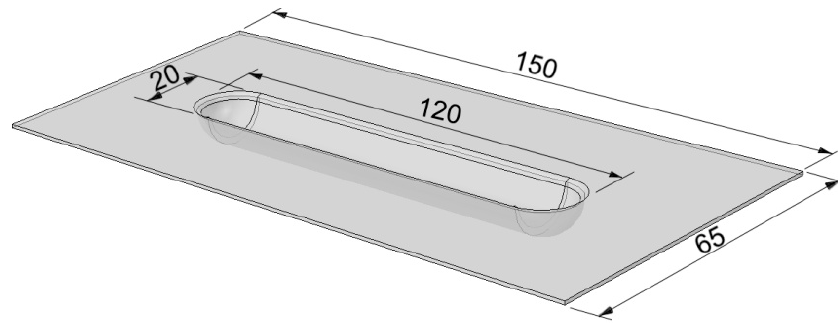
Figure 9. Shape and dimensions of the rib-stiffened panel.